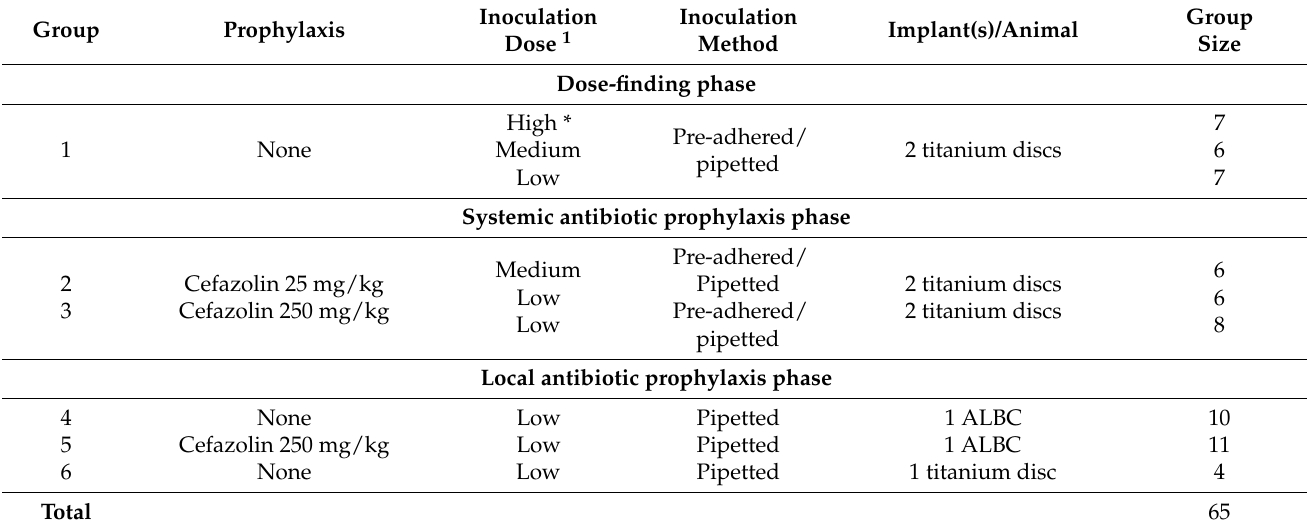
Table 1. Overview of study design.